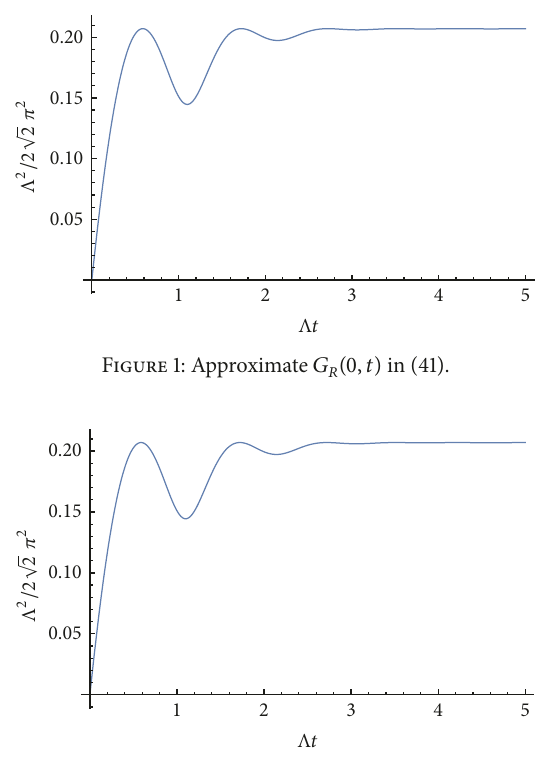
Figure 2: 𝐺 푅 (0, 𝑡) derived by numerical